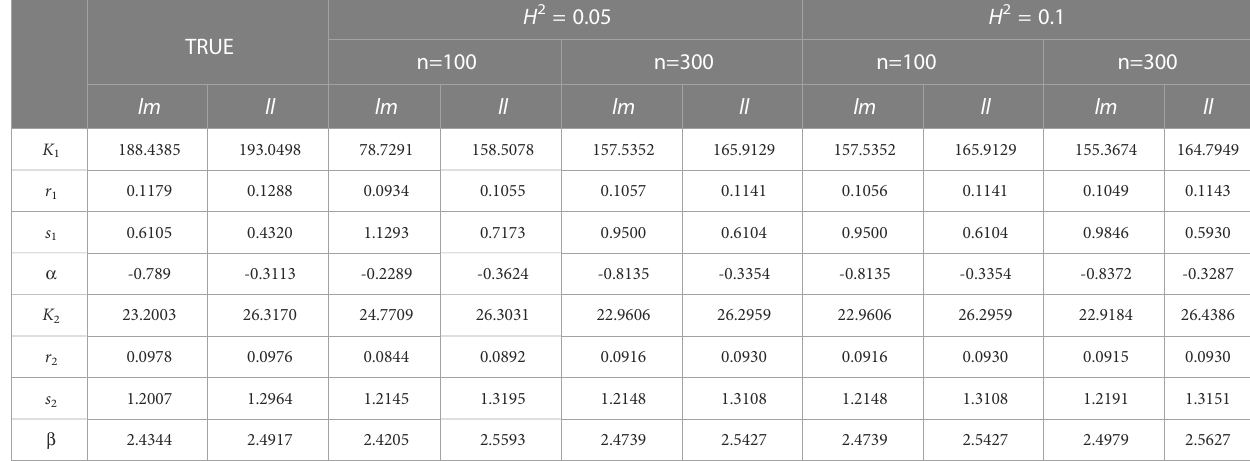
TABLE 3 Comparison between the real parameter set and the parameter set of simulation experiment results for root number (count) and root length (cm) . H 2 = 0.05 H 2 = 0.1 TRUE